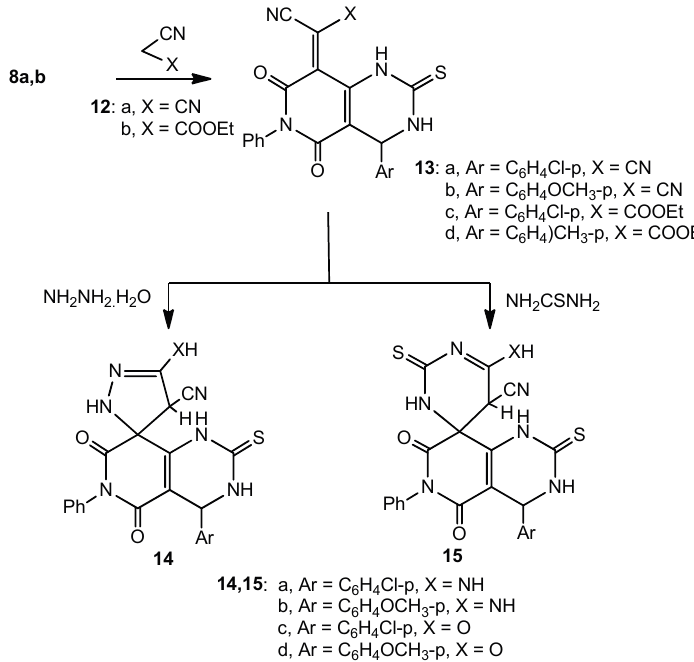
Scheme 3. Reaction of 8a , b with activated methylene compounds followed by binucleophiles; formation of 14a – d and 15a – d